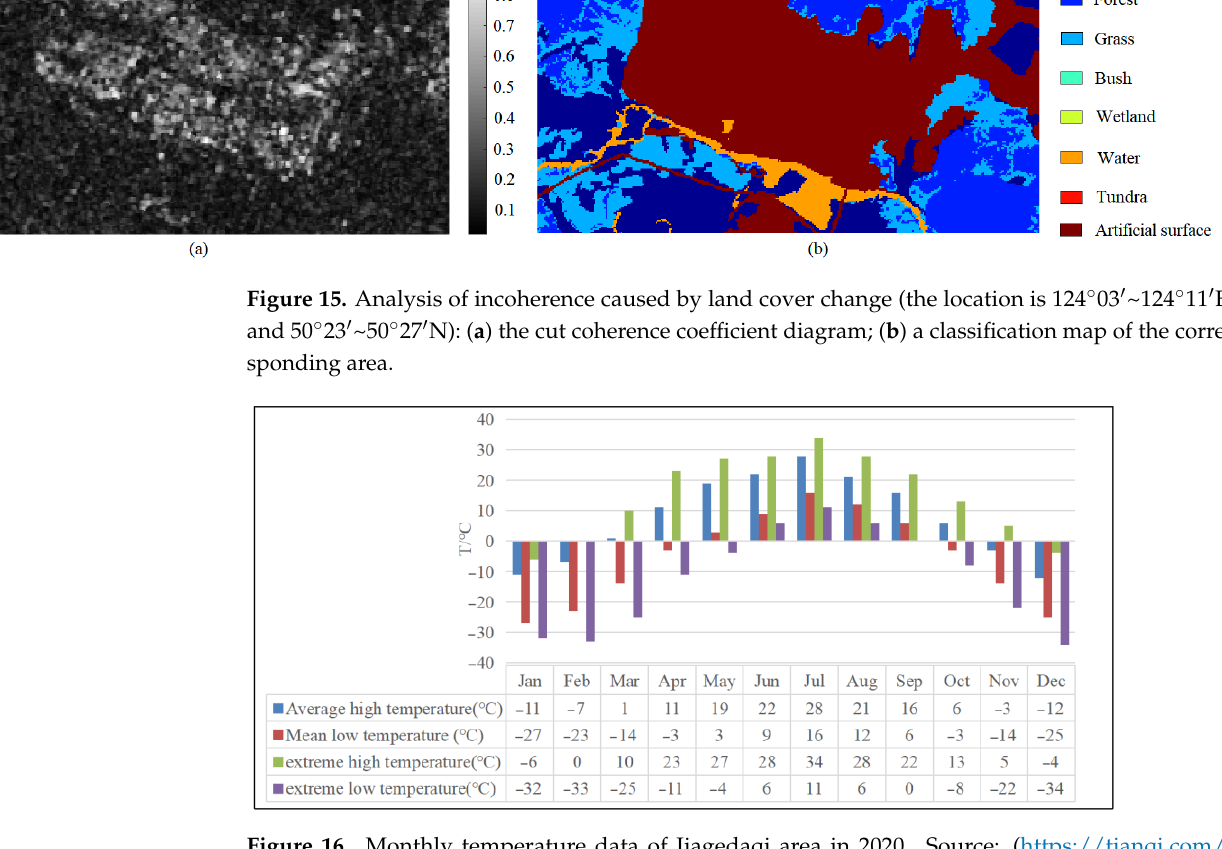
Figure 16. Monthly temperature data of Jiagedaqi area in 2020. Source: (https://tianqi.com/, accessed on 3 January 2022).